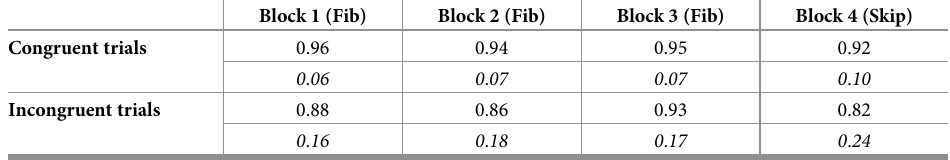
Table 4. Mean ( Standard Deviation ) accuracy in each condition for each block for congruent and incongruent tri- als (Analysis 2).